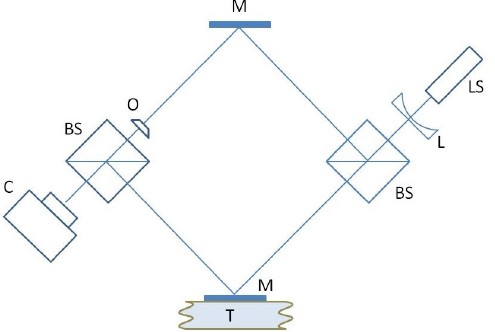
Figure 9. Optical scheme, registration of digital holograms; LS—laser source, L—lens, BS—beam splitter, M—mirror, T—translator, O—object,